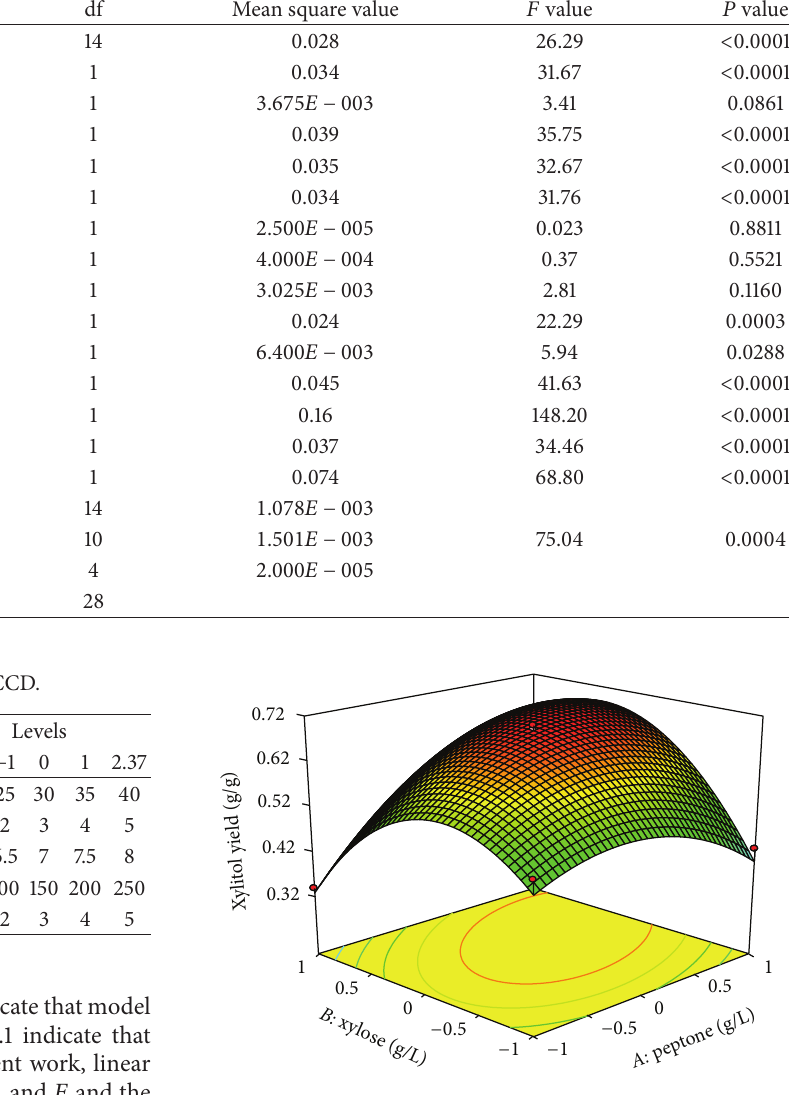
Figure2:3Dplotshowingtheeffectofpeptoneandxyloseonxylitol